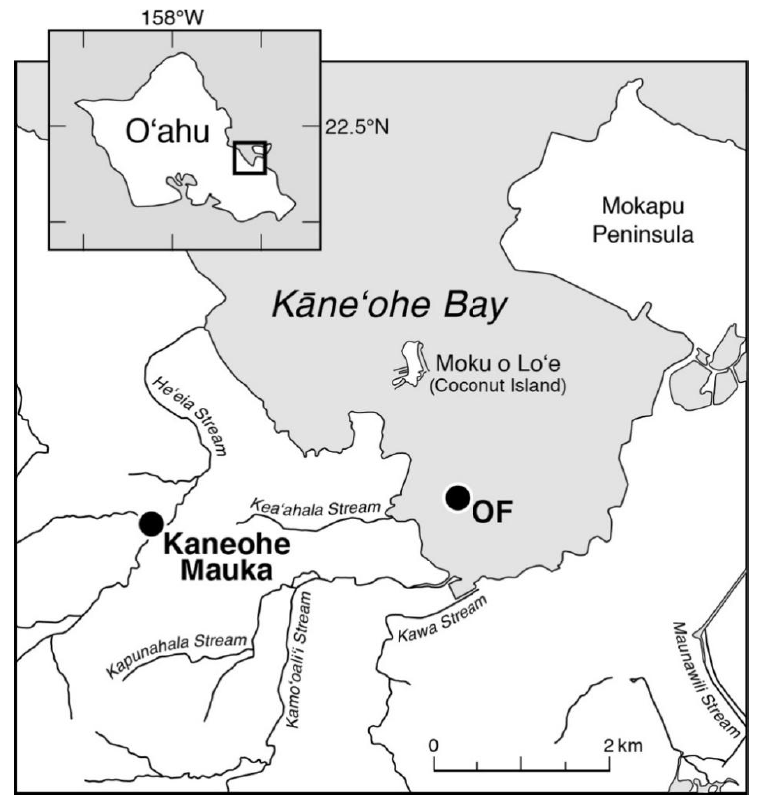
Figure 1. The location of the sampling site (OF) in the southeast sector of Kaneohe Bay and of the U.S. Weather Bureau Kaneohe Mauka rain gauge.